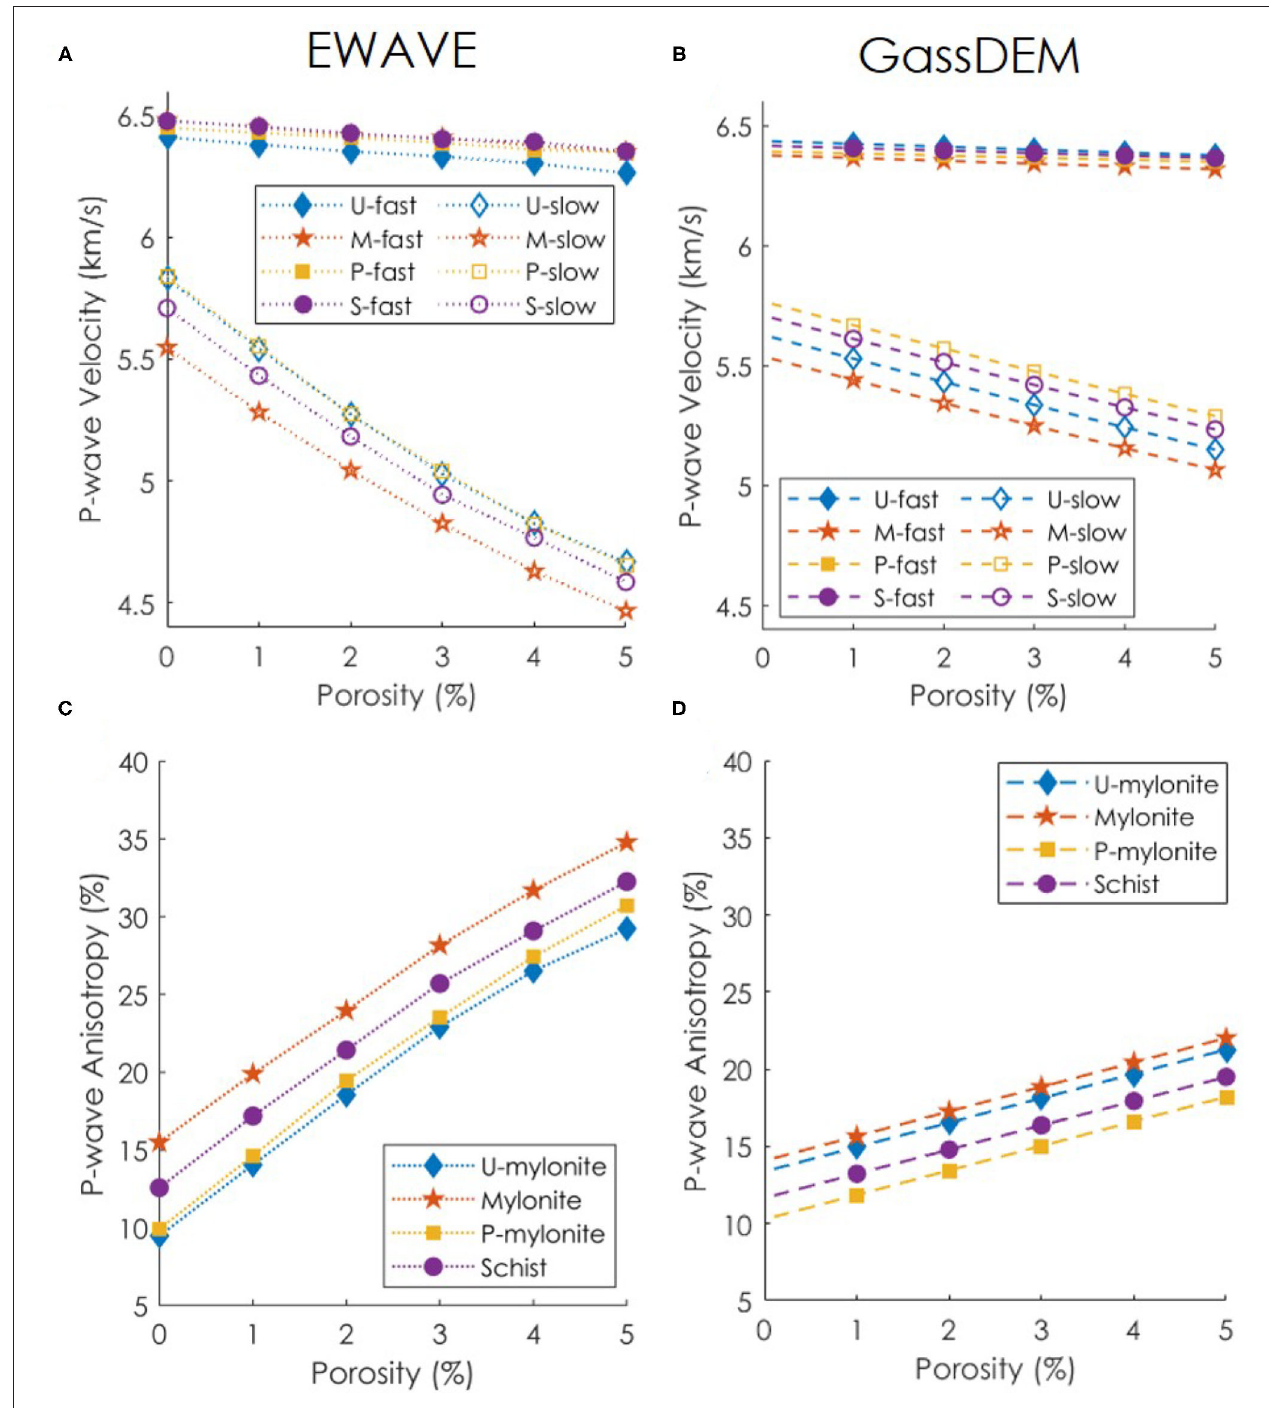
FIGURE 8 | Modeled P-wave velocity and anisotropy with (A,C) EWAVE model (5:1 fracture aspect ratio) and (B,D) GassDEM model (5:2:1 fracture aspect ratio). U, M, P, S refer to ultramylonite, mylonite, protomylonite and schist, respectively. -fast and -slow refer to fast and slow velocity.